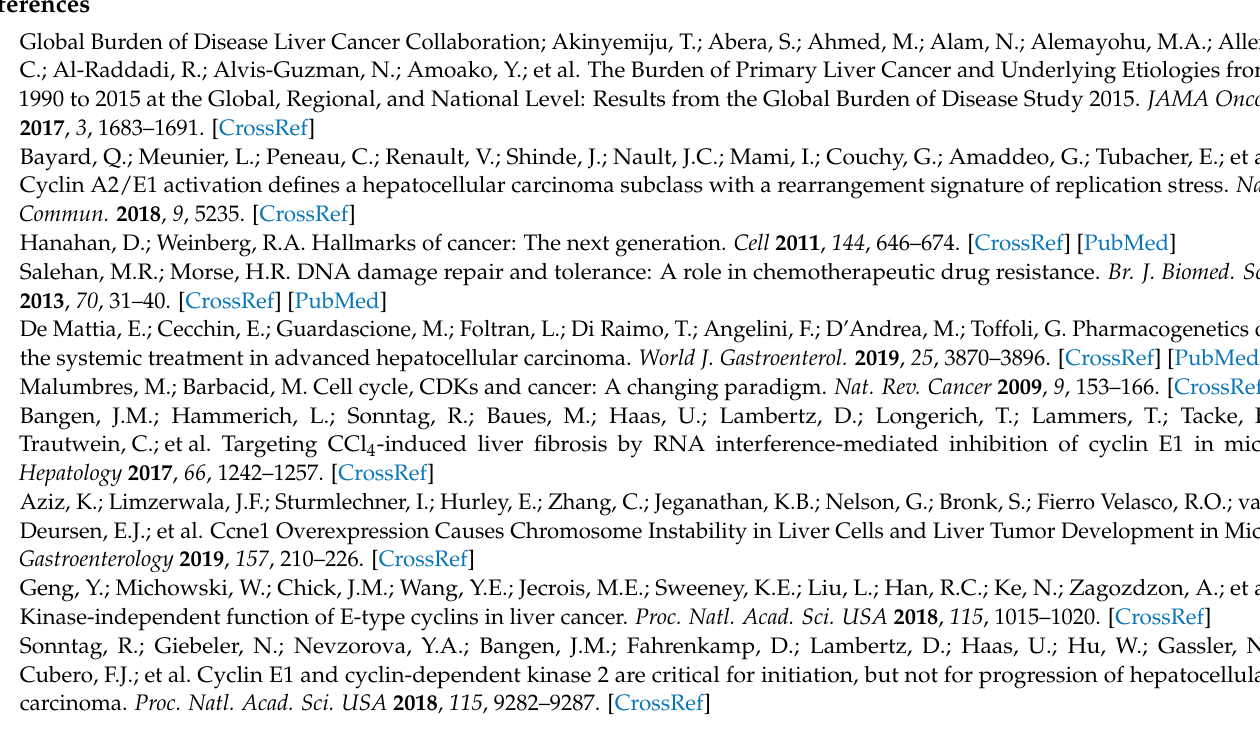
R. R (2017); Table S3: Primer sequences for quantitative real-time PCR; Table S4: Primer sequences for genotyping PCR; Table S5: Antibodies for Western Blot, immunofluorescence and flow